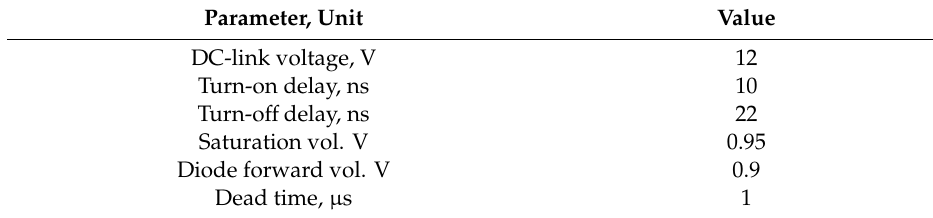
Table 2. Specifications of voltage source inverters